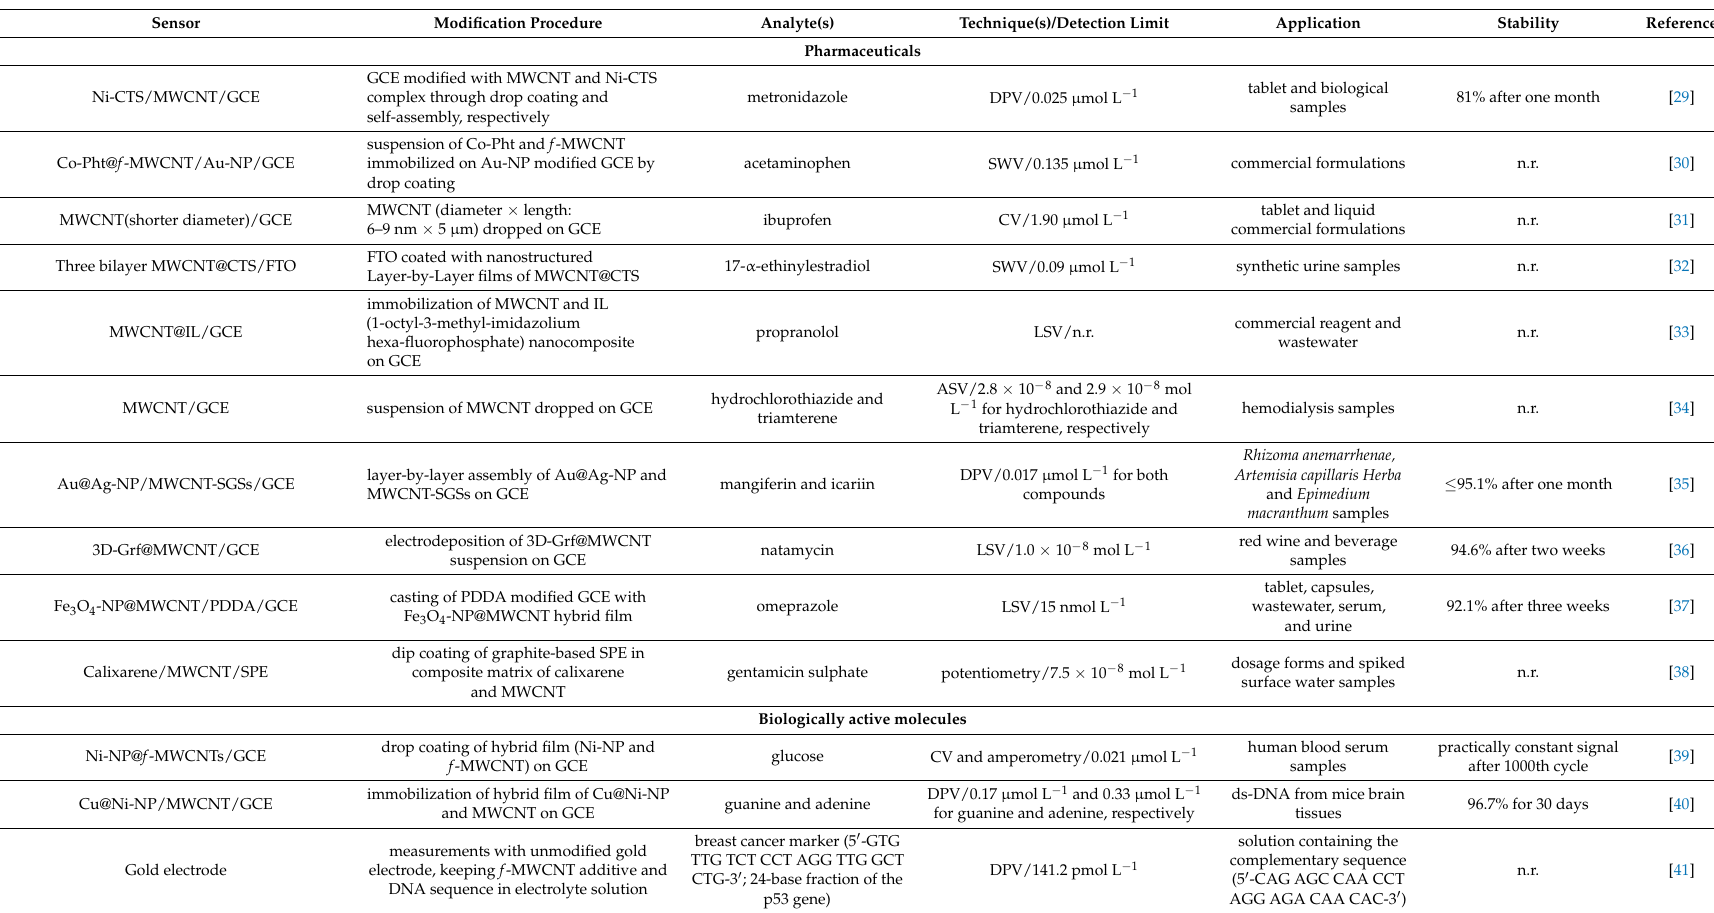
Table 1. Configuration, analytical performance and application of electrochemical sensors based on multi-walled carbon